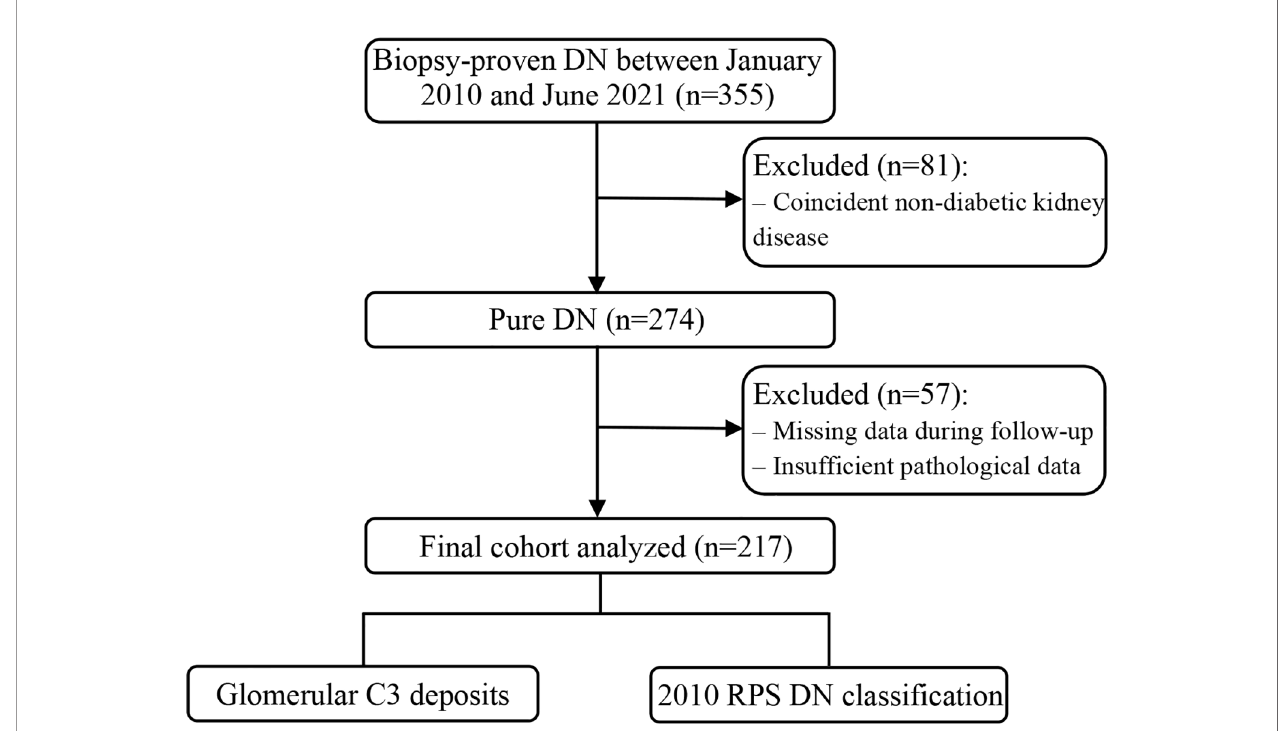
FIGURE 1 | Flow chart of the study participants. DN, diabetic nephropathy; RPS, Renal Pathology